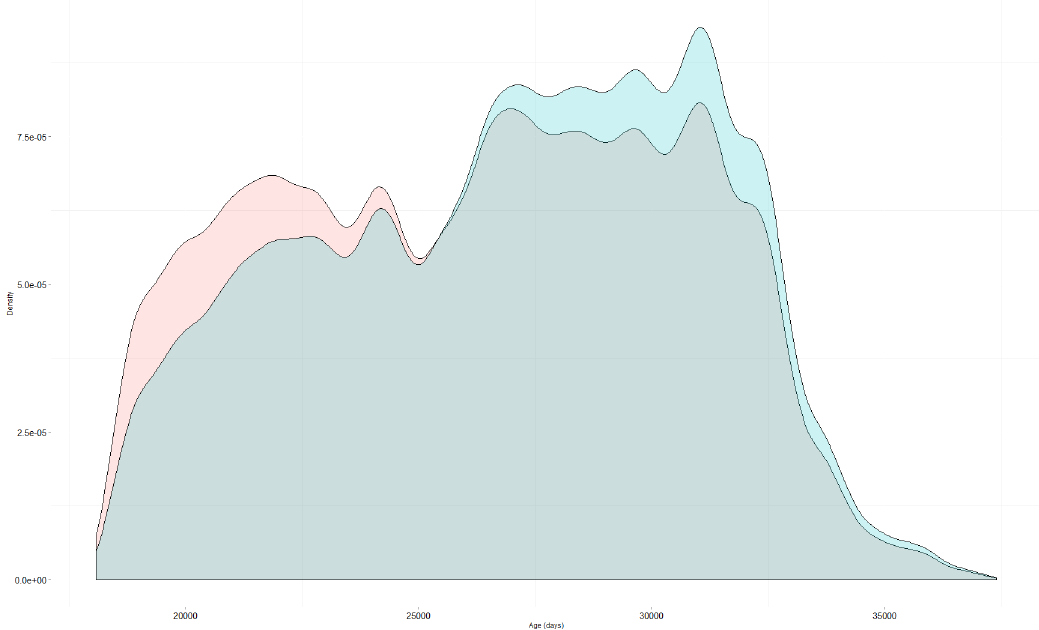
Fig 1. Density plot for age, in days, from random sampling (red, M t ) and from covariate (age)-dependent sampling (blue, M th . age